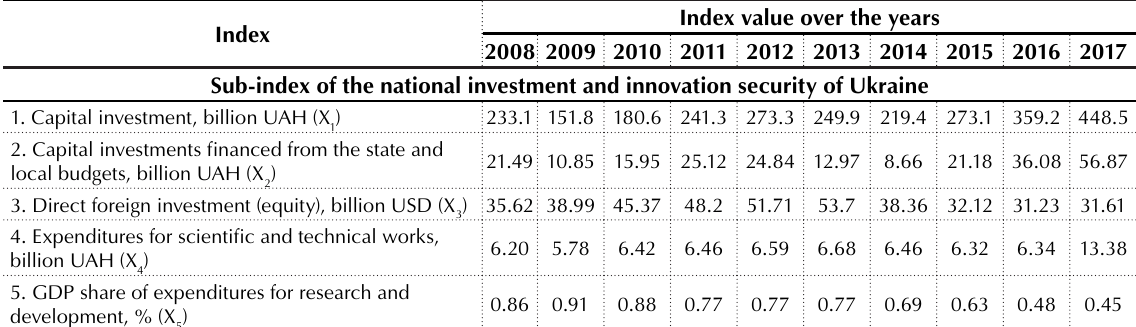
Table 3. Dynamics of single indices of the investment and innovation security components in Ukraine